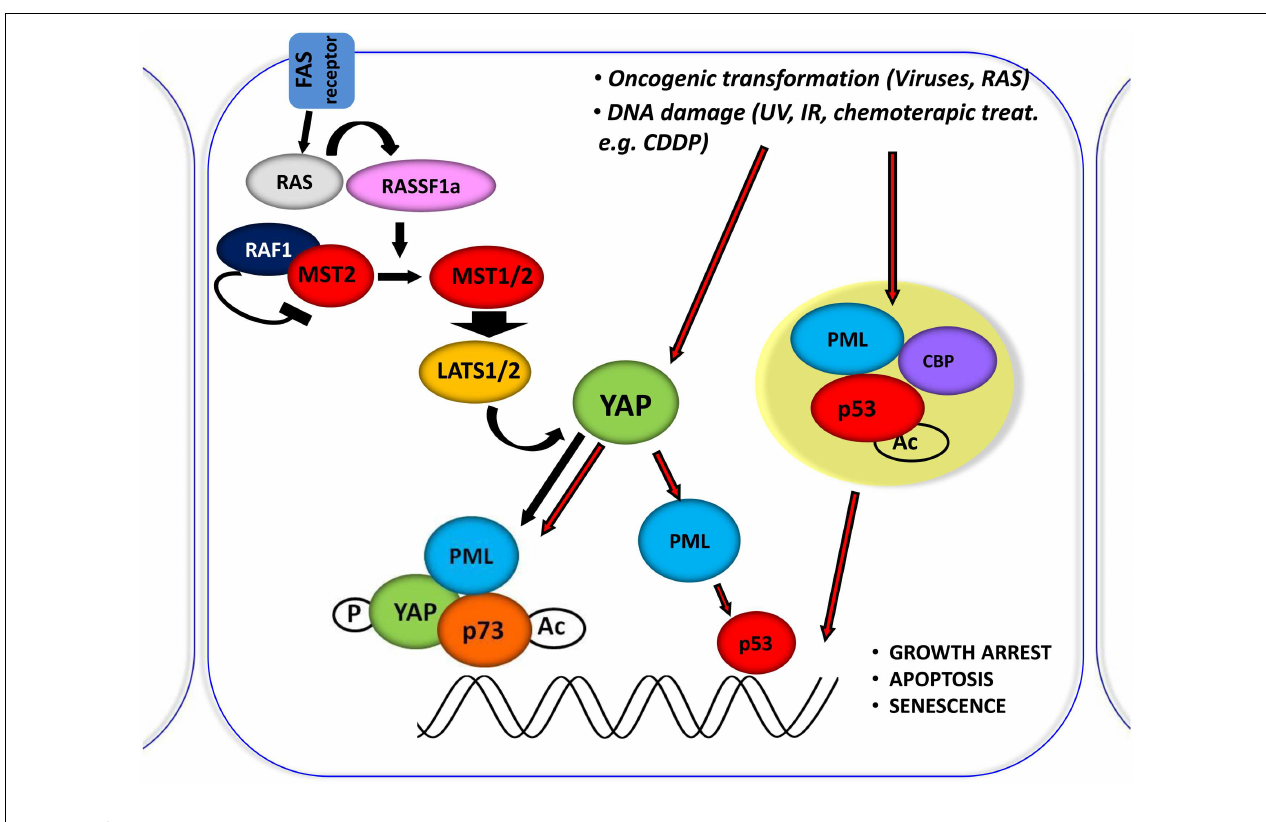
FIGURE 3 | Central role ofYAP in proliferation inhibiting pathways. Schematic representation of the central role ofYAP in inducing the inhibition of proliferation, by integrating and mediating different upstream stimuli. It was shown that RASSF1A disrupts the inhibitory complex between RAF1 and MST2 and favors the physical association between